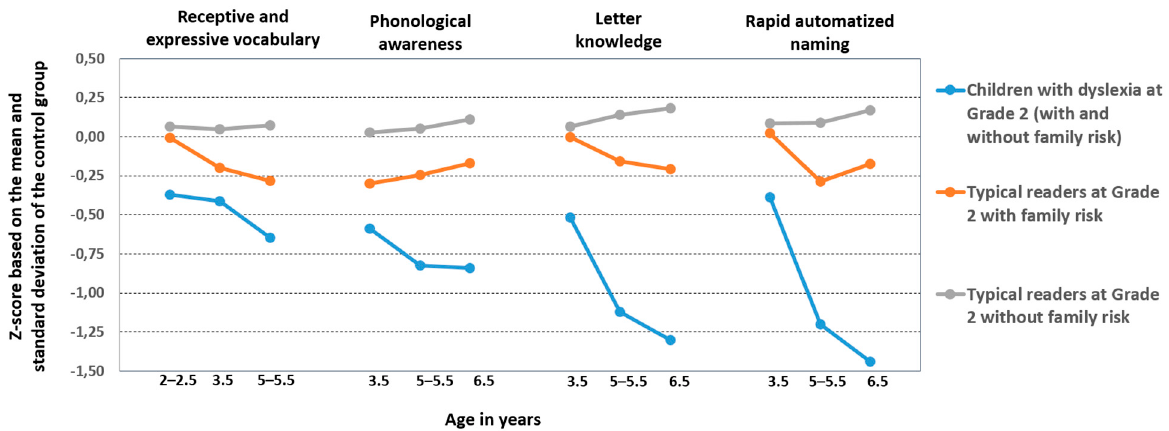
Figure 3. Group means of the key cognitive predictors of reading